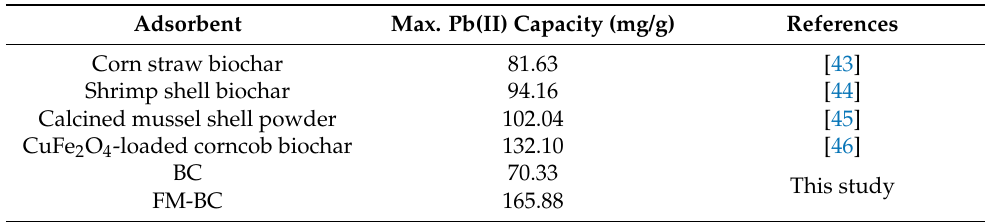
Table 2. Comparison of sorption capacity of adsorbents for Pb(II).